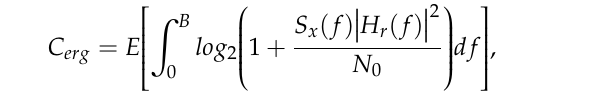
Figure 14. Data rate of the hybrid tracking system and electromagnetic tracking system.